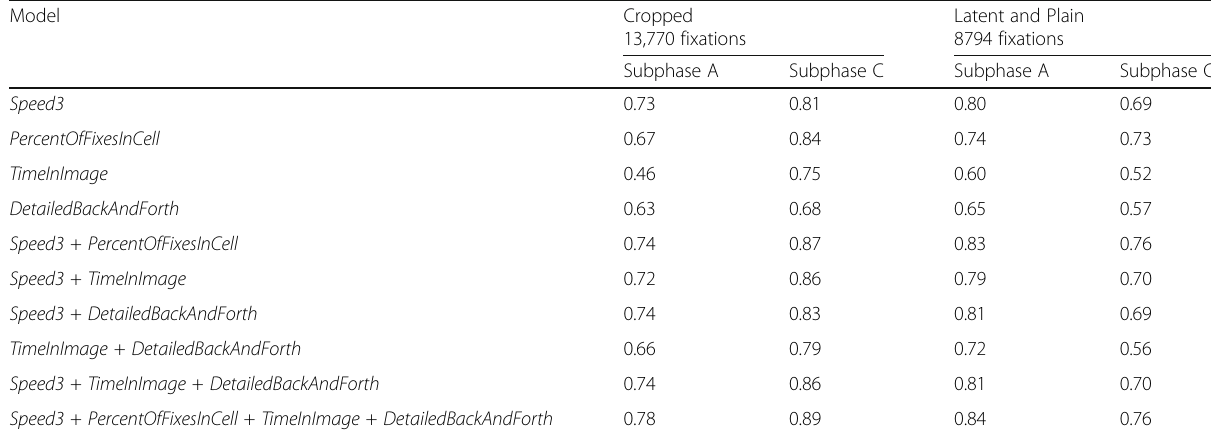
Table 3 Performance of logistic regression models predicting the subphase or location of fixations ( n = 22,747 Comparison-phase fixations on the right image from 675 trials). Model performance is compared using area under the (receiver operating characteristic) curve (AUC). No cross-terms were used in these models: each model had one degree of freedom for each predictor